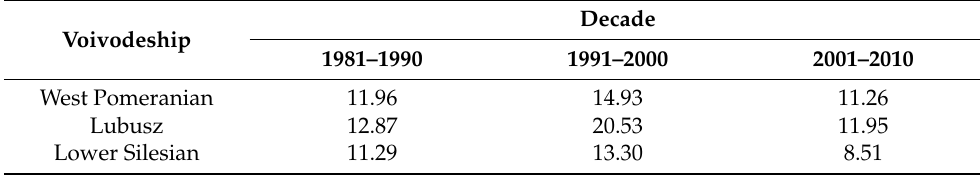
Figure 9. Average water needs of willow in each decade (10-year periods) from 1981 to 2010 for the analyzed voivodeships. Table 5. Values of standard deviation (SD) for decadal data for each voivodship.